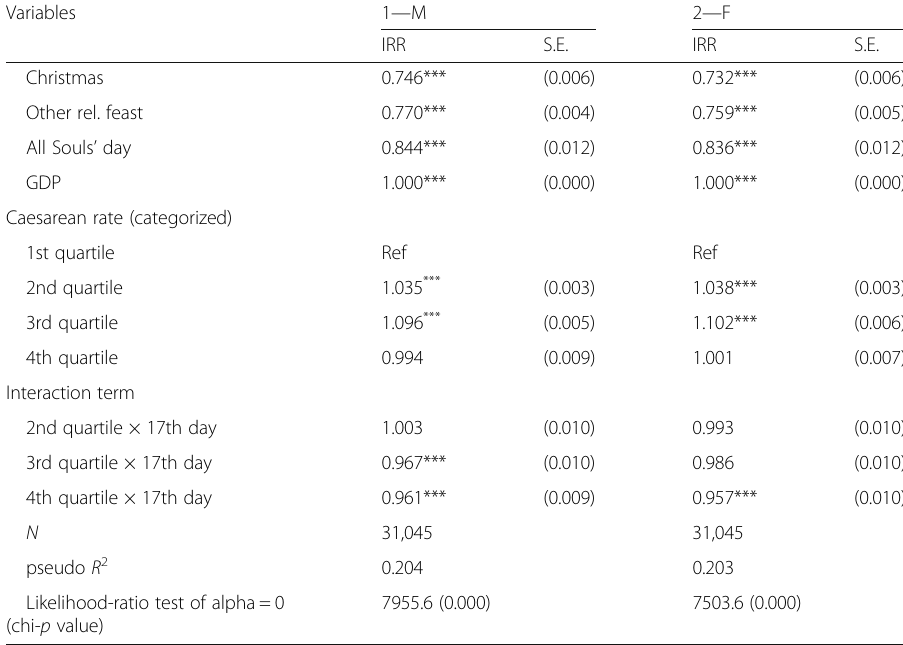
Table 4 The calendar effect on the daily births pooling macro-regions (Continued)